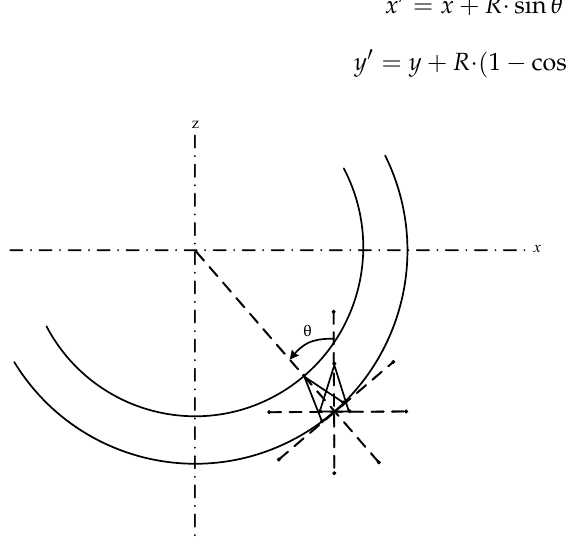
Figure 12. Coordinate system for equator welding simulation.